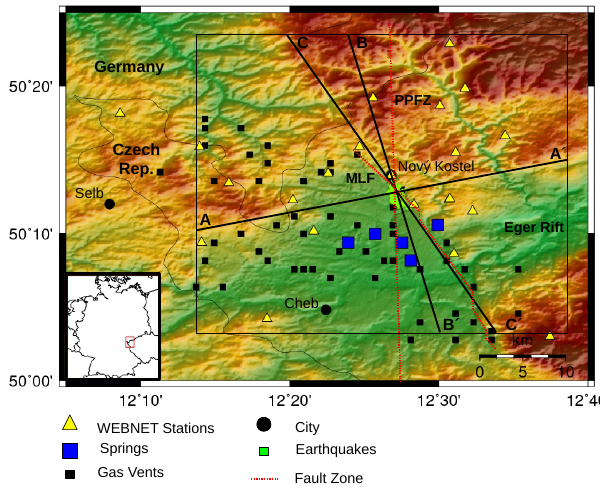
Figure 1. Topographic map showing the Nový Kostel Seismic Zone. Inset shows location within Europe. Black box shows inversion area and lines A-A 0 , B-B 0 and C-C 0 note profiles shown in other fig- ures. Abbreviations: MLF – Mariánské-Láznˇe Fault Zone, PPFZ – Poˇcátky-Plesná Fault Zone. Mineral spring and gas vent locations digitized from Heinicke et al.